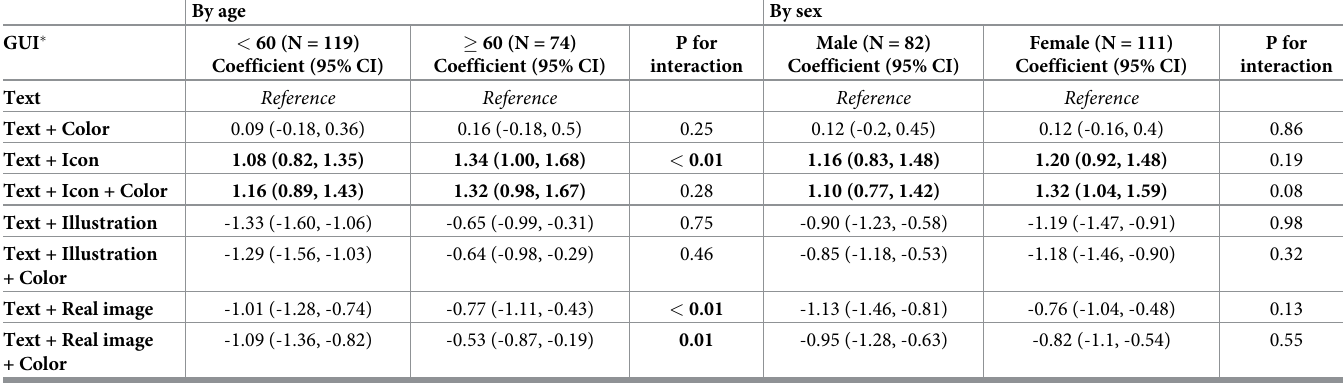
Table 3. Subgroup analysis for multivariable mixed linear regression to compare score of understanding of terms according to graphical user interface (GUI) design. By